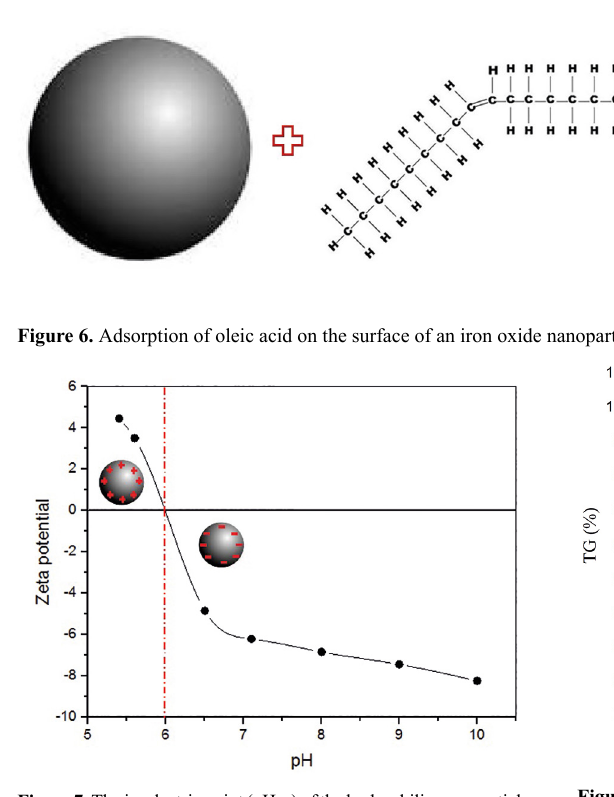
Figure 7. The isoelectric point (pH